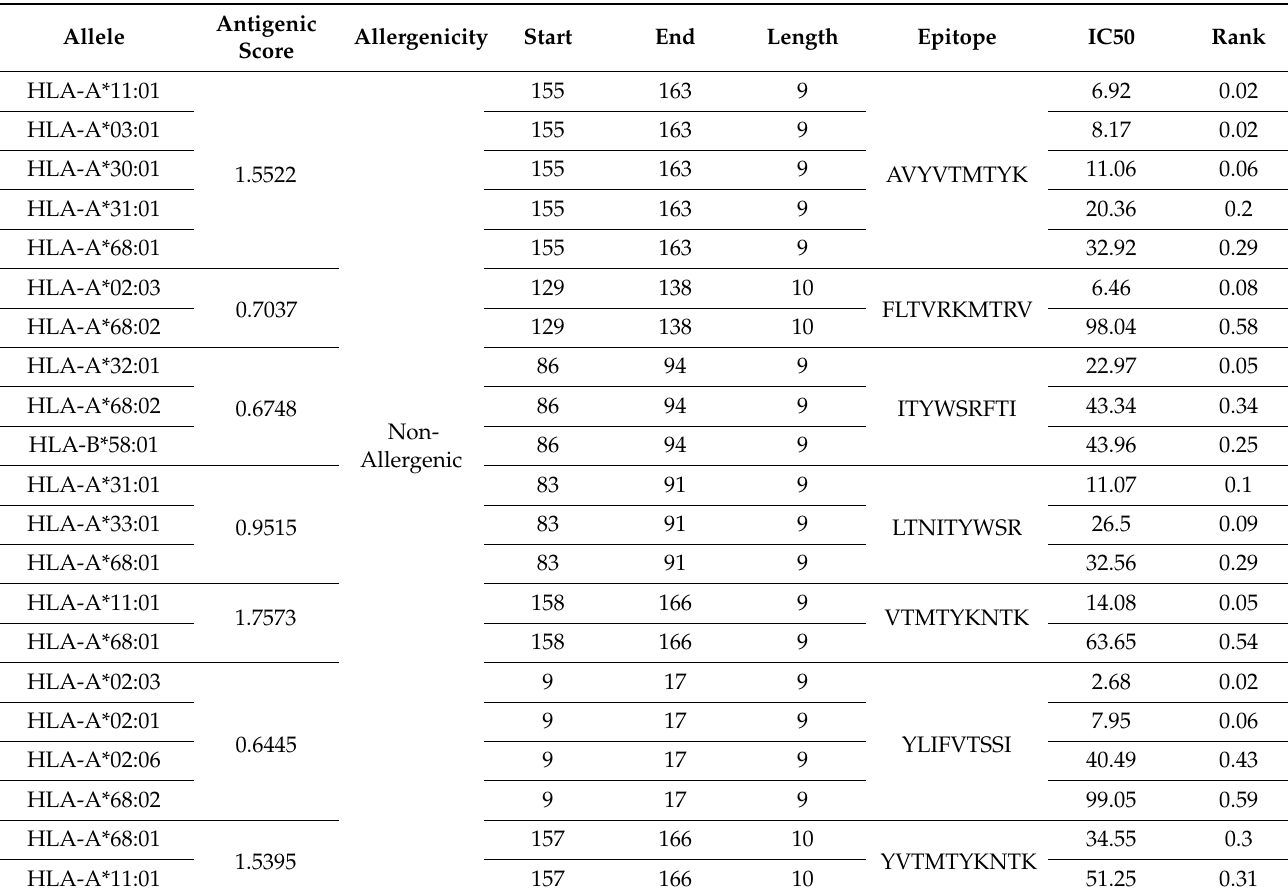
Table 2. MHC Class-I epitopes.